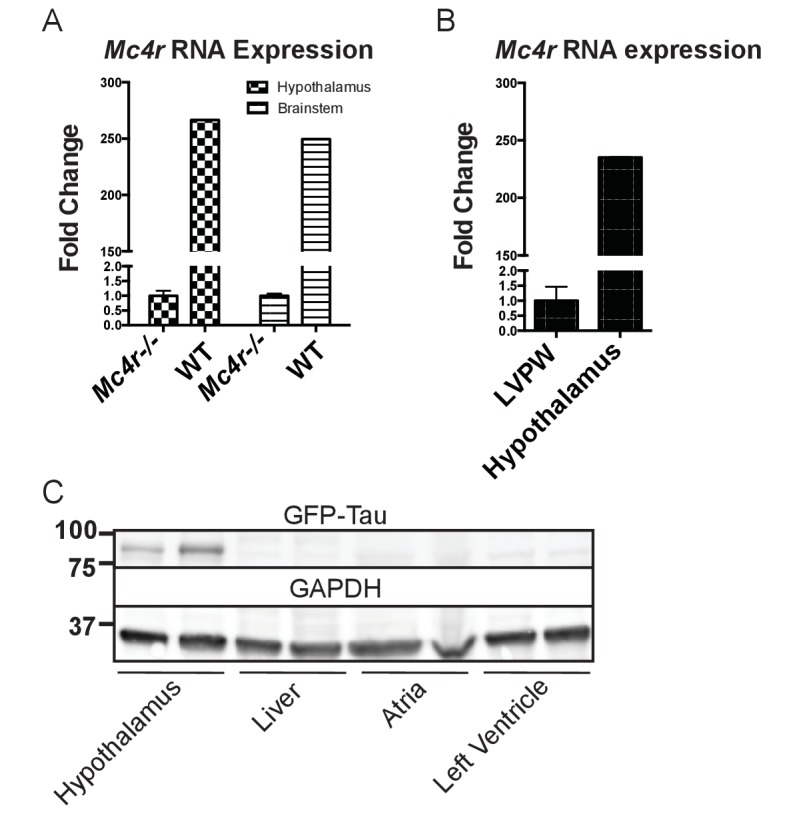
Mc4r is not expressed in adult heart tissue.(A) qRT-PCR comparison of Mc4r expression in heart and hypothalamus using the ΔΔCT method. (Student’s t-test, p<0.0001, n = 8) (B) qRT-PCR comparison of Mc4r expression in the hypothalamus and brainstem between Mc4r−/− and WT tissue demonstrating dynamic range of qRT-PCR primers (Student’s t-test, p<0.0001, n = 8). (C) Representative western blot of Mc4r -Tau-Sapp hypothalamic, hepatic, atrial and ventricular lysates.10.7554/eLife.28118.009Figure 4—source data 1.Source data for Figure 4A–B.This source file provides mean, SD, sample size and statistical test information for all qRT-PCR experiments in Figure 4.